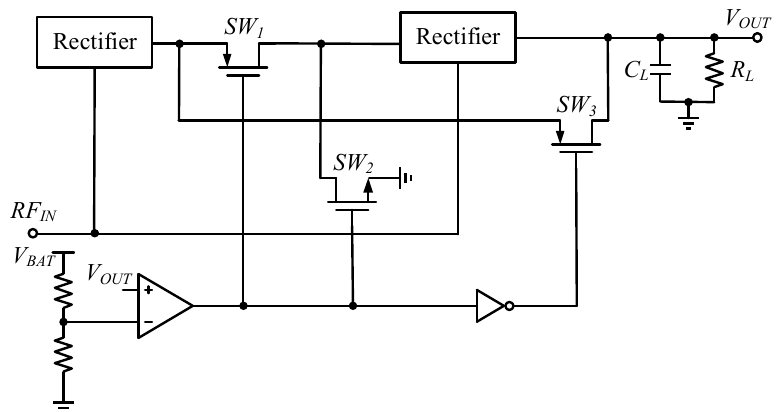
Figure 14. The reconfigurable RF–DC power converter.